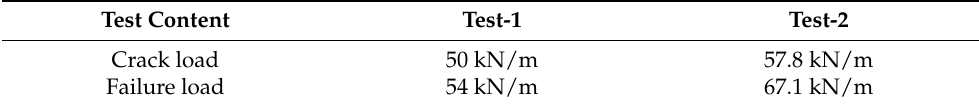
Table 5. Results of a three-edge bearing test for a complex cross-section reinforced concrete pipe.